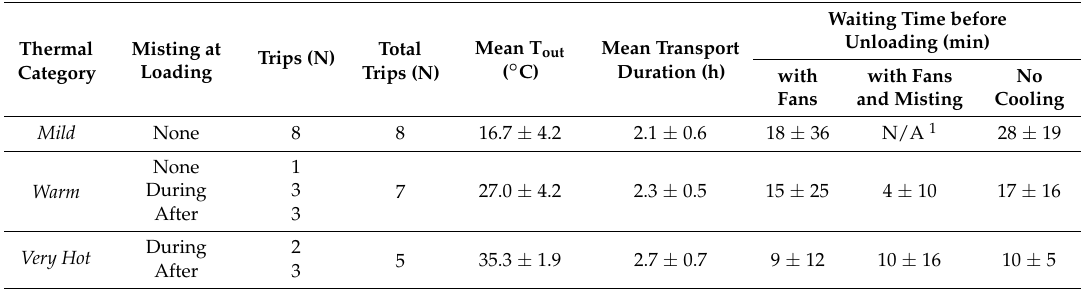
Table 2. Descriptive statistics for 20 monitored transport trips categorized as thermal categories Mild , Warm , and Very Hot